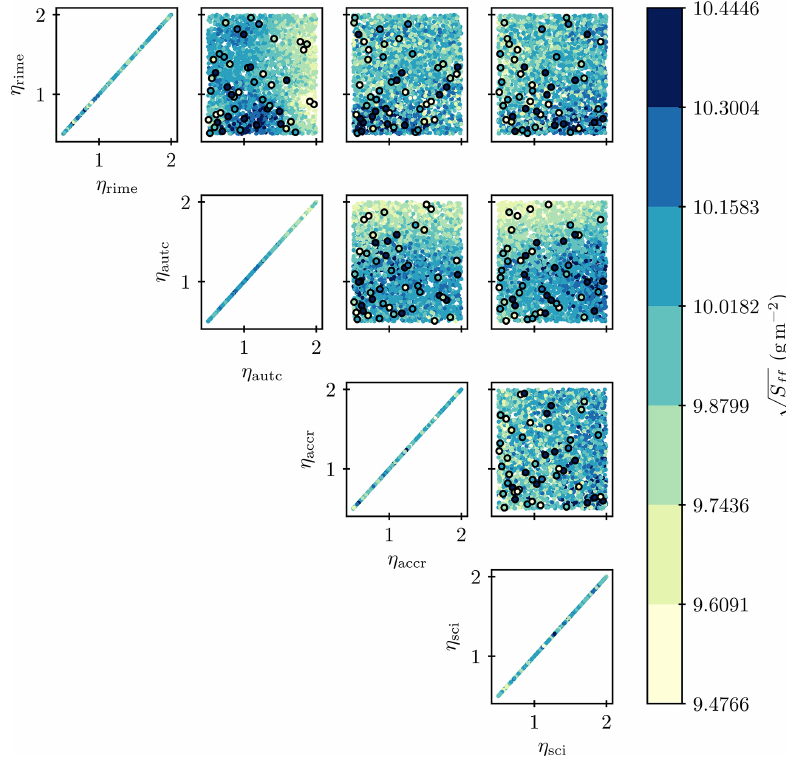
Figure D2. Same as Fig. 7 but for the LWP spherical expansion angular amplitude spectrum of degree l = 3. In this case, the emulator was found to be defaulting; it therefore failed the validation and was not included in the subsequent sensitivity analysis. The points enclosed by black circles denote the PPE member results used to train the